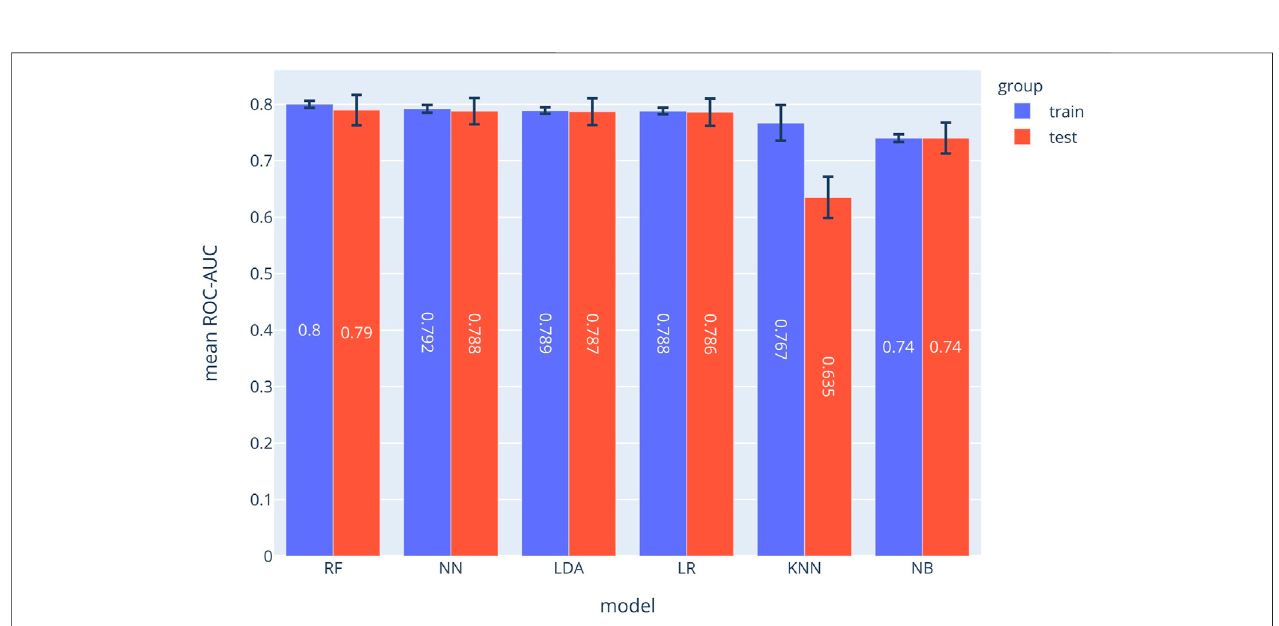
shown in Supplementary Figure S1 . Supplementary Figure S2 delineates each method ’ s performance for all symptoms as a Radar chart.